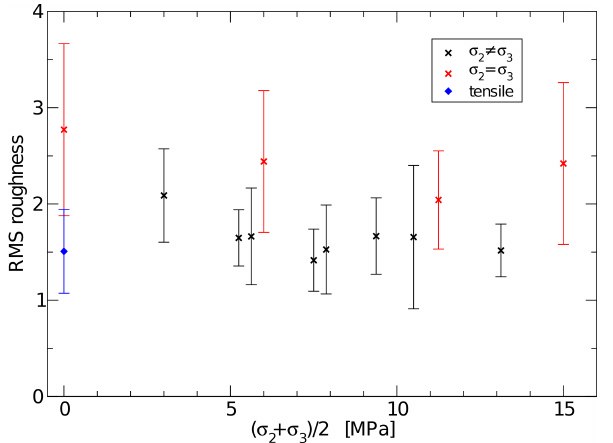
Figure 10. Log–log plot of the height–height correlation function of a fracture surface generated in a numerical deformation experiment (red diamonds) and a “quasi-planar” surface generated by cutting the particle packing used in the experiment with a plane (black cir-